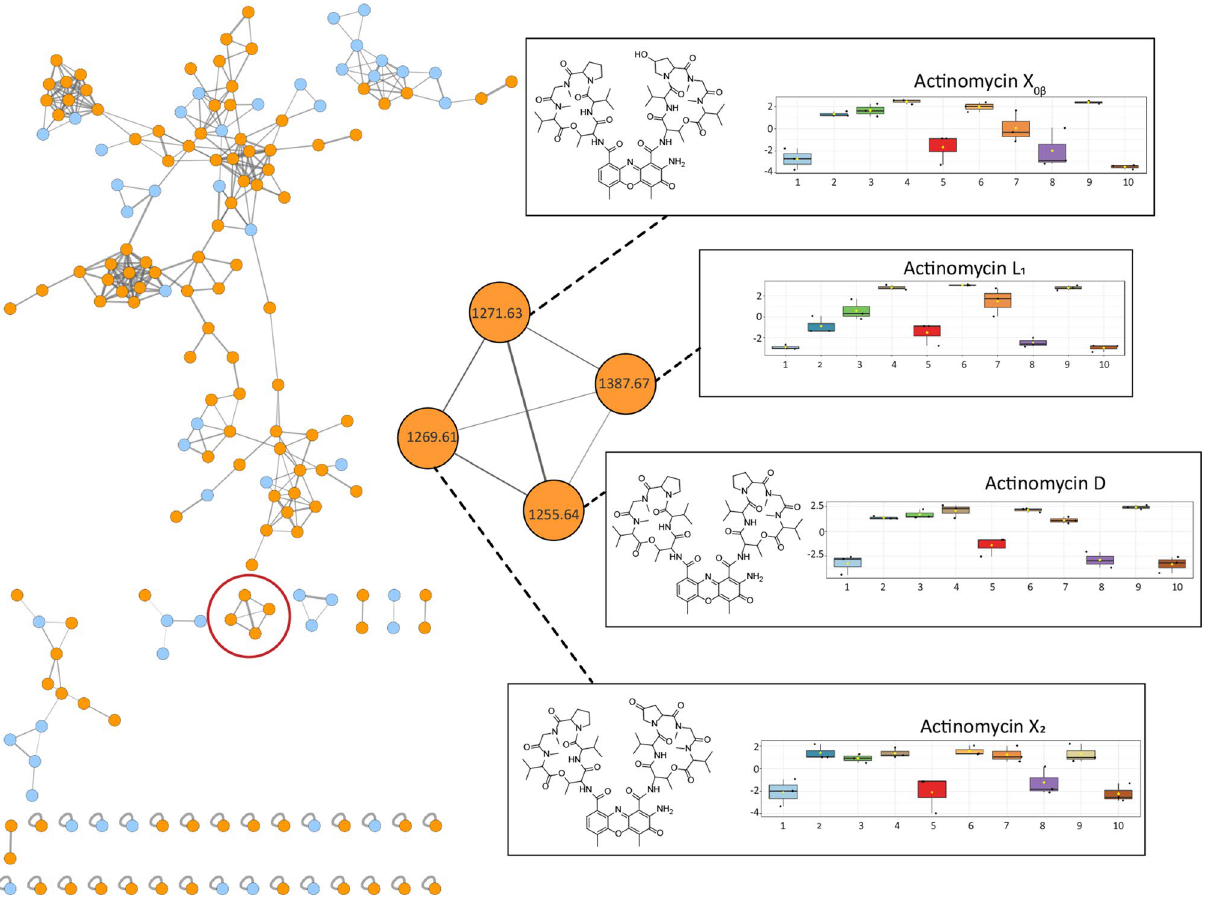
Figure 2. GNPS molecular network of the ions detected in the crude extract of Streptomyces sp. MBT27. Cultures were grown for seven days in MM with 1% glycerol. Orange nodes represent ions of the metabolites produced by Streptomyces sp. MBT27, while blue nodes represent those of the media components. The actinomycin spectral family is enlarged. Results of ANOVA statistical analysis were mapped onto the molecular network to illustrate the differential production of actinomycin cluster members under various growth conditions. Box plots represent relative intensities of actinomycins X 2 , X 0β , and D after log transformation and pareto scaling; together with a compound with an m/z value of 1387.67, in cultures grown in MM with the following carbon sources: 1. 1% arabinose; 2. 1% fructose; 3. 1% GlcNAc; 4. 1% glucose; 5. 2% glucose; 6. 1% glycerol; 7. 2% glycerol; 8. 1% mannitol; 9. 1% mannitol + 1% glycerol; 10. 2% mannitol (%ages in